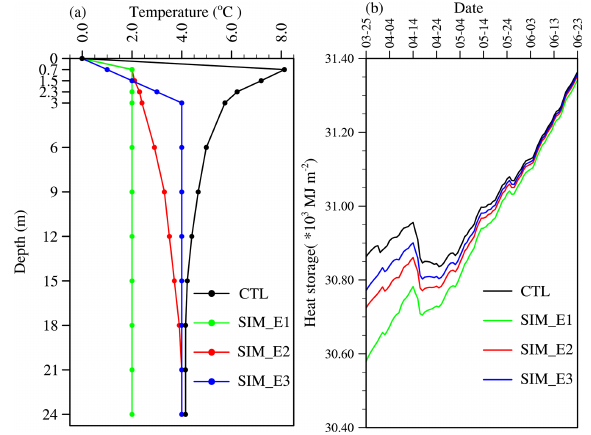
Figure 7. (a) The initial water temperature profiles in the model are set on 25 March 2016, and the corresponding daily average (b) lake heat storage is simulated. SIM_E1, SIM_E2, and SIM_E3 are three different sensitivity